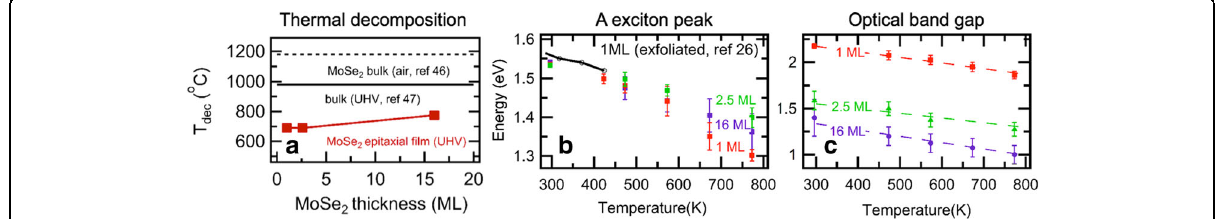
Fig. 4 a T dec of MoSe 2 bulk and thin films in air or UHV conditions. Red squares are from the temperature-dependent optical spectra on the MoSe 2 epitaxial films, while black solid and dashed lines correspond to the bulk MoSe 2 in UHV [47] and air [46] condition in the literatures. b Temperature dependence of the A exciton peaks in imaginary part of dielectric functions in Fig. 3d – f. Black open circles indicate the A exciton peak values of the exfoliated 1-ML MoSe 2 taken in the previous report [26]. c Temperature dependence of the optical band gap values for the 1, 2.5, and 16 ML of MoSe 2 films, taken from the absorption spectra